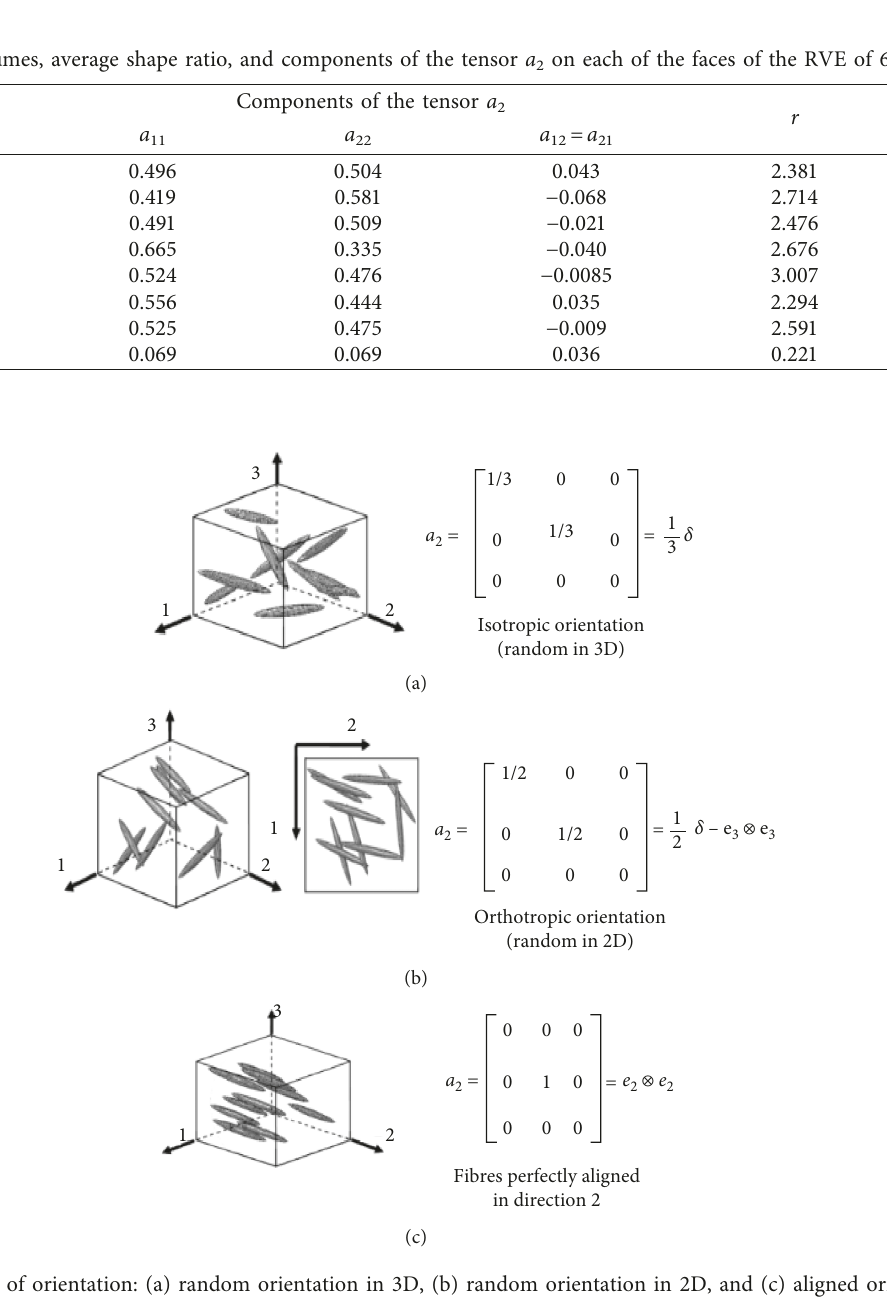
Table 5: Fraction volumes, average shape ratio, and components of the tensor a